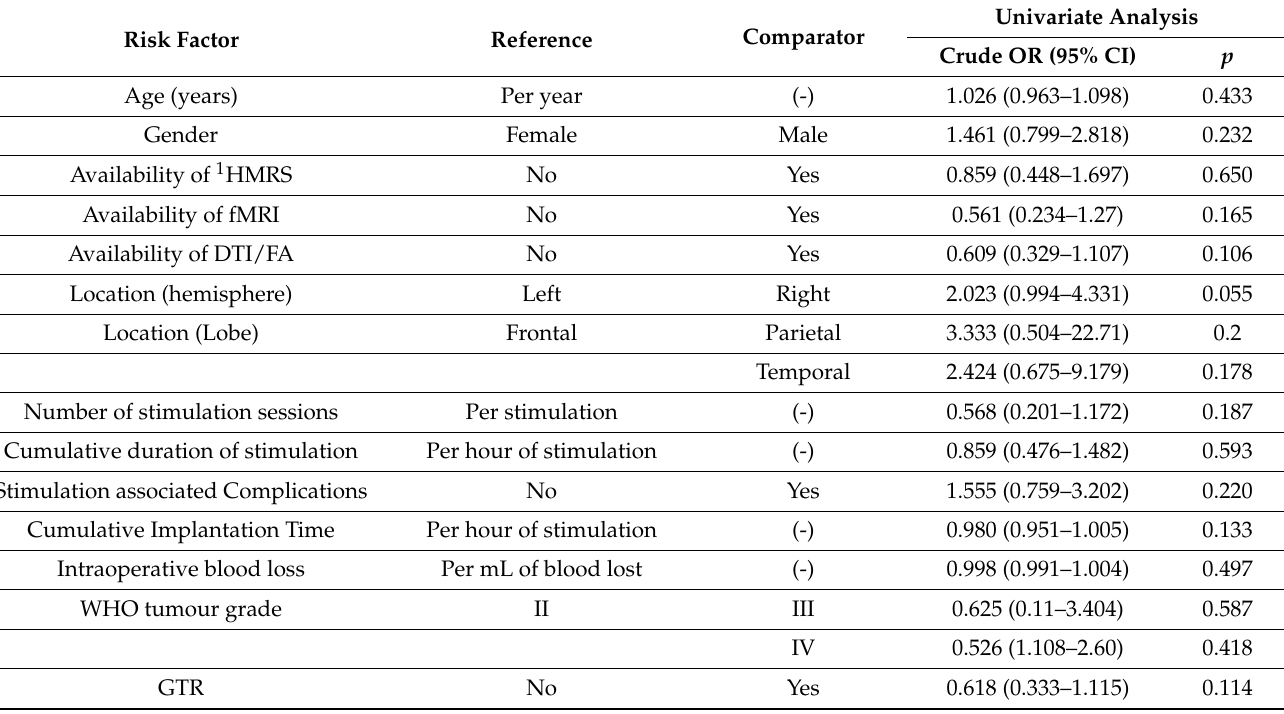
Table 4. The univariate logistic regression analysis identified no predisposing factors for perioperative complication